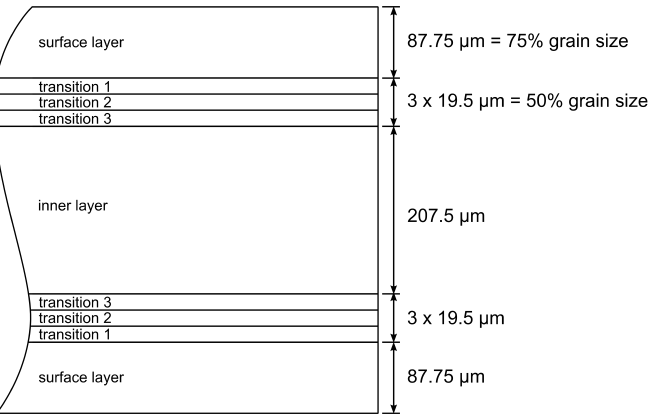
Figure 15. Sectioning of the electrical steel sheet for the FEA of the shear cutting process Electrical steel samples of the evaluated material are shear cut with an experimental shear cutting tool on the mechanical Bruderer press BSTA510-125. The cutting force-punch travel curve was measured during the punching operation. These data were used to calibrate the simulation model by multiplying the flow curves of the different sections with a best fit scaling factor of 1.4 and by adjusting the damage criterion. Figure 16 shows the simulated and smoothed punch force over punch travel for the surface model and the homogeneous model as well as the smoothed experimental punch force-punch travel curves. The slope of the simulated curves is much higher since the stiffness of the press machine was neglected in the FEA. Apart from that, the surface model results in a typically shaped cutting force-punch travel curve of the shear cutting